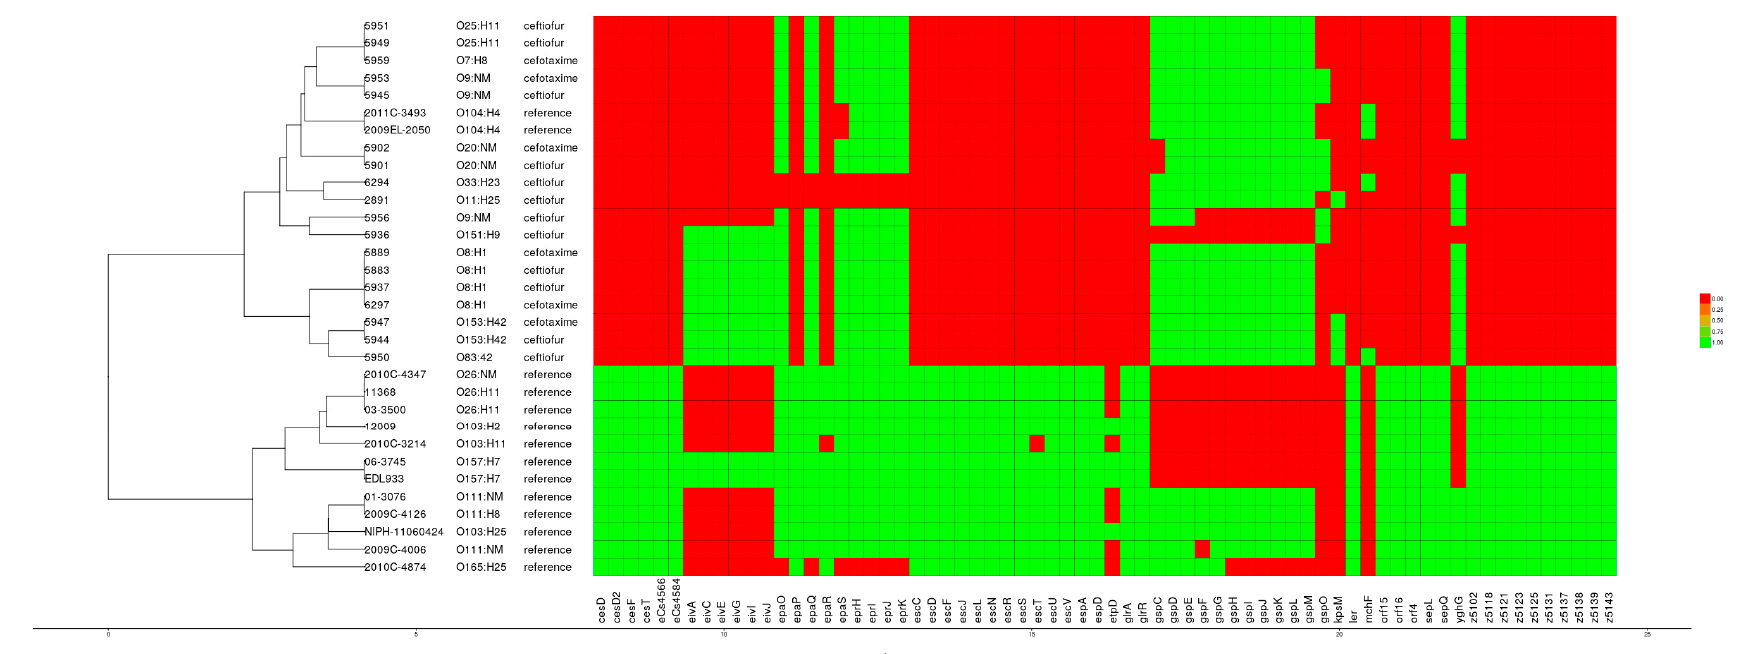
Figure 3. Heat map showing the presence (green color) and absence (red color) of ( a ) 38 adherence factors; ( b ) 24 iron uptake proteins; ( c ) 22 toxins; and, ( d ) secretions factors, across 18 TIO or FOX resistant from day cow manure and 14 pathogenic reference E. coli genomes. The bottom labels indicate the gene names. The tree on the left show a hierarchical clustering of the labelled strains based on the genes profile.